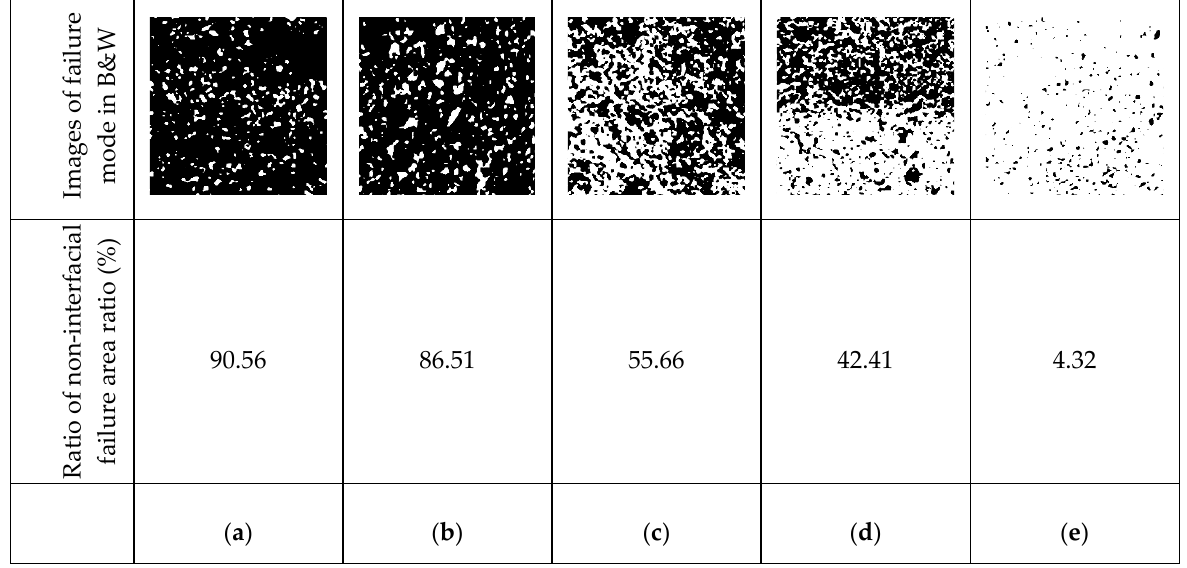
Figure 13. Ratio of non-interfacial failure area to total area. ( a ) Zn; ( b ) Zn/Al; ( c ) Al; ( d ) Cu/Zn; ( e ) Cu/Sn.